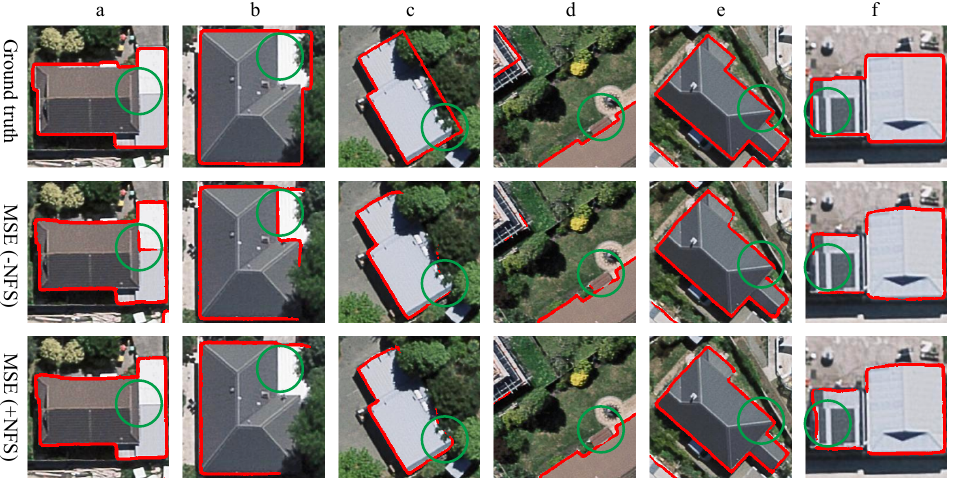
Figure 10. Representative results of outlines extracted from model trained by mean square error (MSE) loss with/without nearest feature selector (NFS). Backgrounds, red lines, and green circles represent aerial input, predicted outline, and focused area, respectively.Selected results are denoted as ( a – f ).